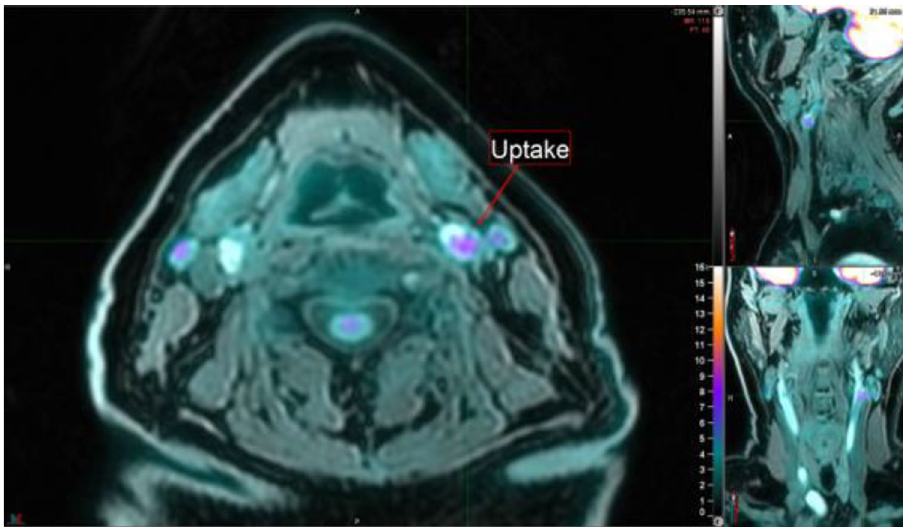
Figure 1. Increased 18 F-FDG uptake in a carotid plaque (shown by the red arrow) in fusion images consisting of T1W MRI and PET. The anatomy of the neck, including the carotid arteries is presented in the axial- (left), sagittal- (upper right) as well as the coronal (lower right) planes. The image was created using MIM,